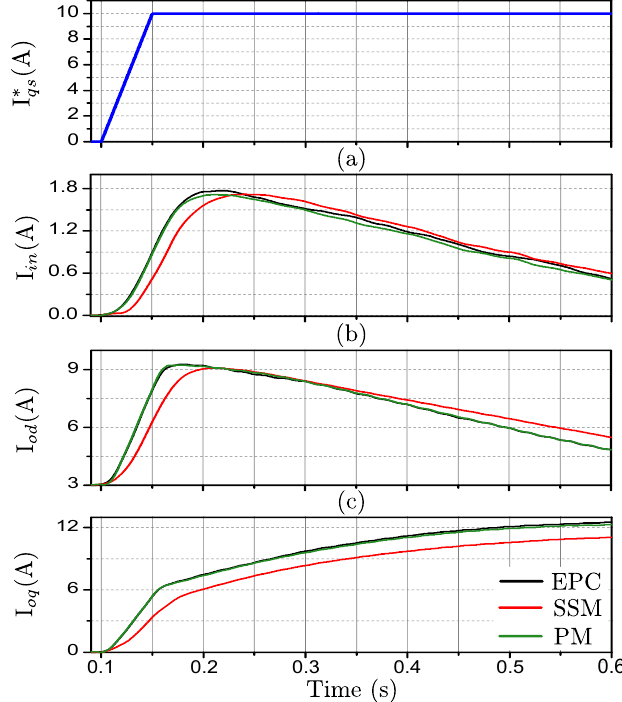
Figure 14. Comparison between ( a ) I in , ( b ) I od and ( c ) I oq of the EPC and the small-signal (SSM) and polytopic models (PM) for a step in I ∗ qs of 10